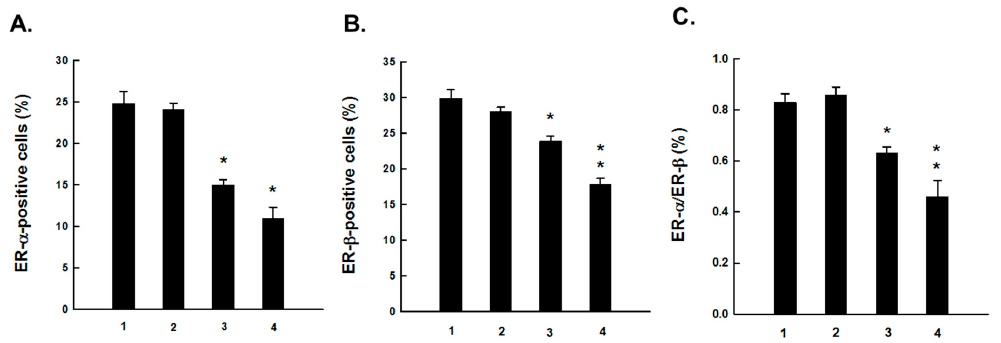
Figure 2. Quantitative analysis of ( A ) ER- α -immunopositive cells; ( B ) ER- β -immunopositive cells and ( C ) ER- α /ER- β ratio during DMBA mammary carcinogenesis in rats in the presence or absence of PE treatment (0.2, 1.0 or 5.0 g/kg). Results are based on 1000 cells per animal and 4 animals per group. Various experimental groups are: (1) DMBA control; (2) PE (0.2 g/kg) + DMBA; (3) PE (1.0 g/kg) + DMBA; and (4) PE (5.0 g/kg) + DMBA. Each bar represents the mean ± SEM ( n = 4). ( A ) * p < 0.001; ( B ) * p < 0.01 and ** p < 0.001 and ( C ) * p < 0.05 and ** p < 0.001 as compared to DMBA control.